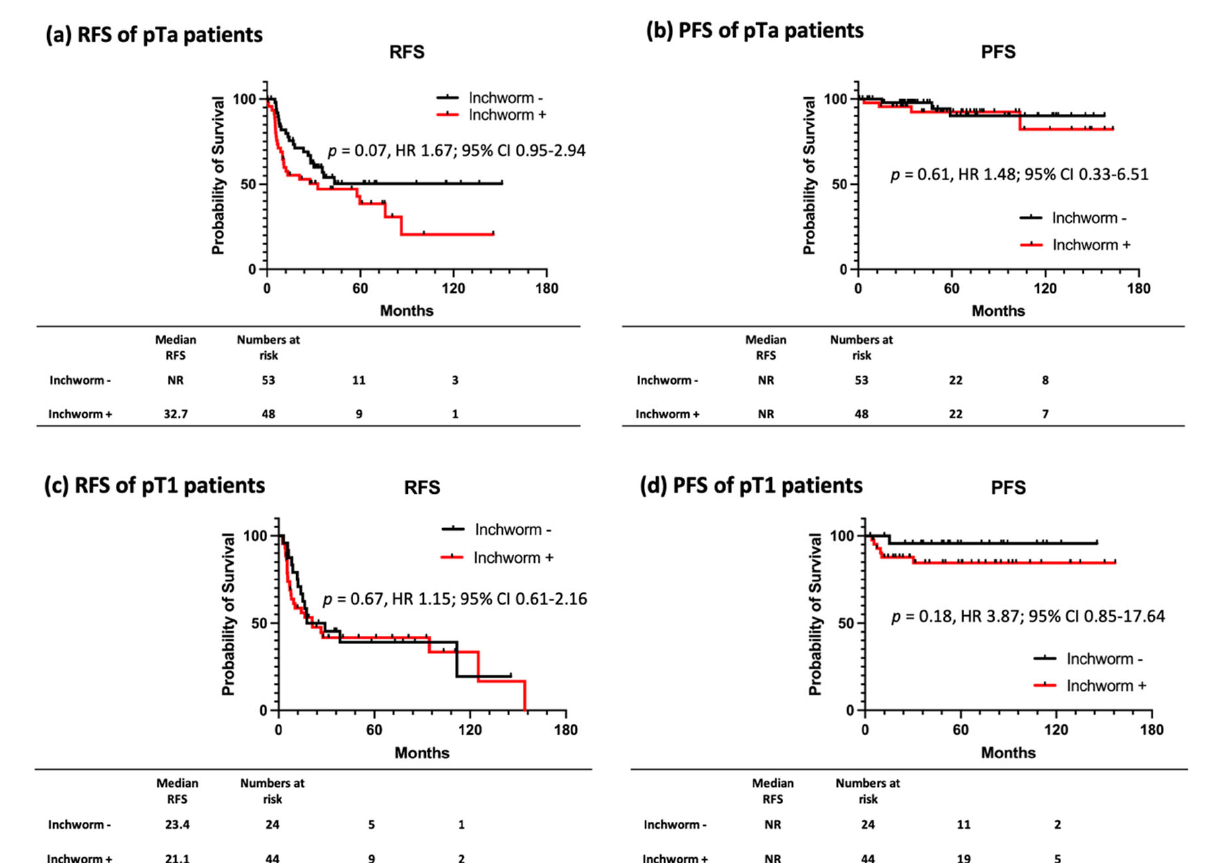
Figure 3. Kaplan − Meier survival curves for recurrence ‐ free survival. (a) Progression − free survival. (b) Stratified by the presence of inchworm sign for patients with NMIBC. Comparison of RFS (HR: 1.49, 95% CI: 0.98 − 2.27; p = 0.06) and PFS (HR: 1.92, 95% CI: 0.62 − 5.96; p = 0.28) between the negative and positive inchworm sign groups shows no significant difference.